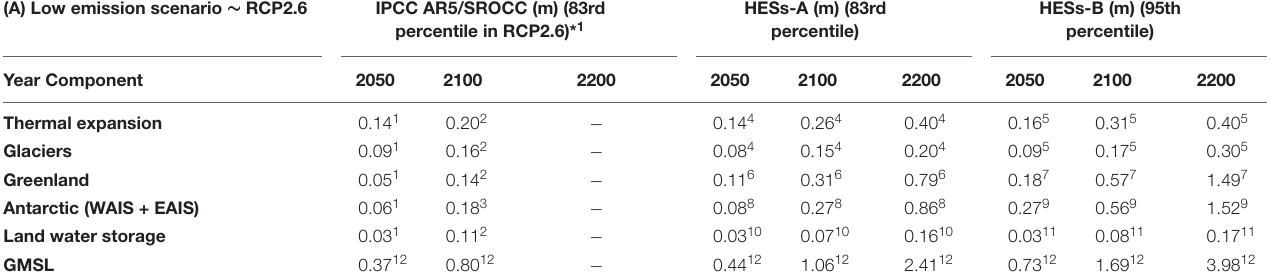
TABLE 1 | (A) Global mean sea-level changes (m) in the low emission scenario by 2100 relative to the end of the 20th century of each sea-level contribution for (left) the IPCC AR5/SROCC upper-end of the likely range (83th percentile), (middle) HESs-A and (right) HESs-B. (A) Low emission scenario ∼